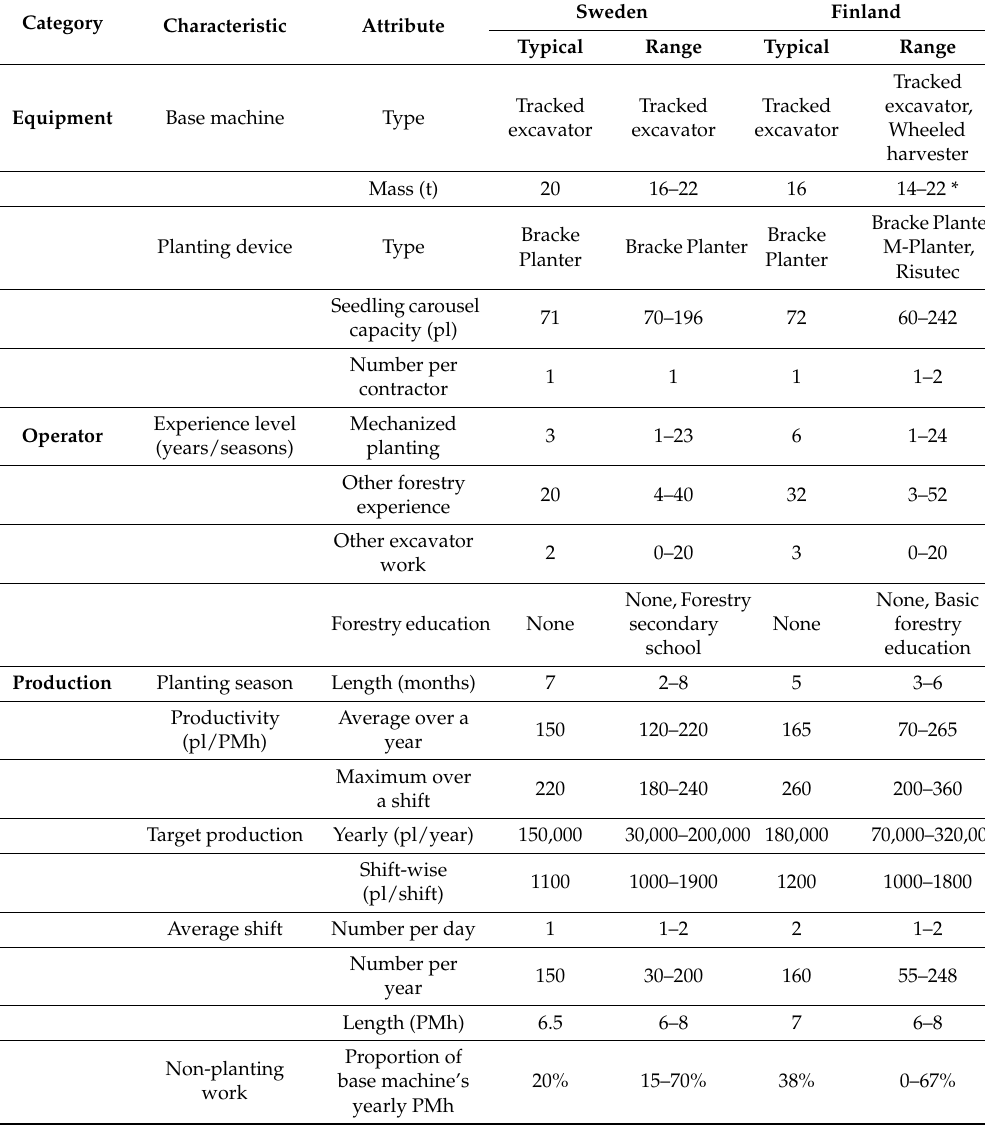
Table 1. Operational characteristics of mechanized tree planting in 2017 in Sweden and Finland (pl = seedlings; PMh = Productive Machine